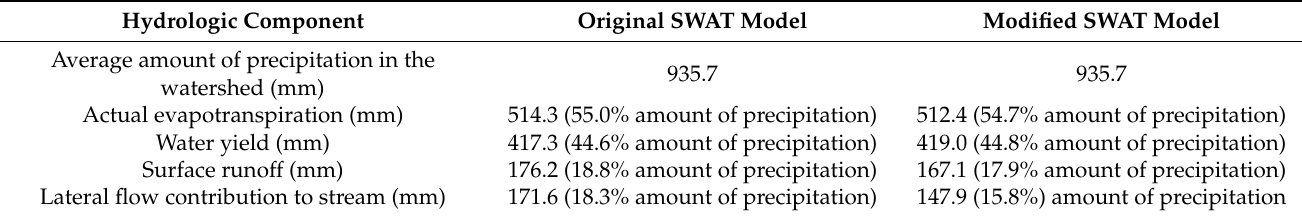
Table 6. Water balance components in the Daotian River watershed calculated using the original and modified SWAT models. Hydrologic